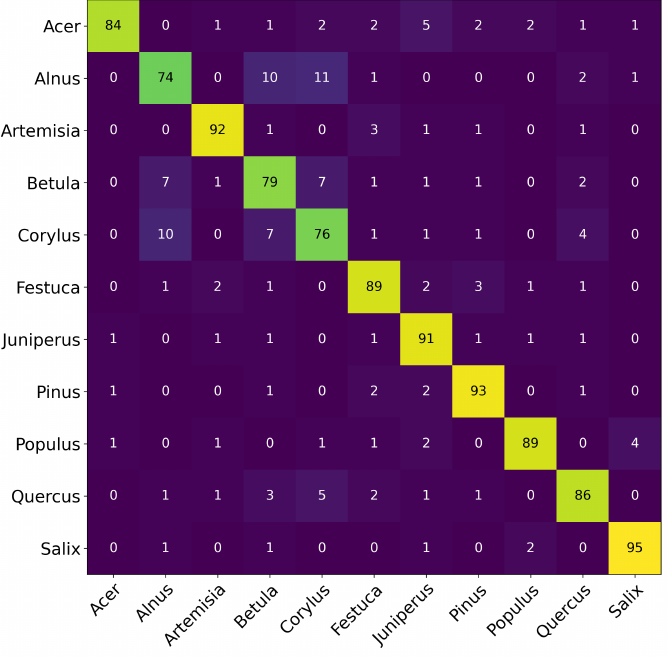
Figure 7. Confusion matrix created on the test set from the SAU-LI dataset. Values are